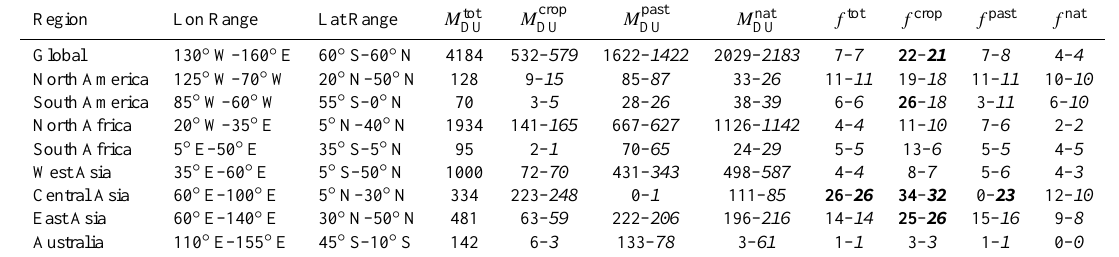
Table 1. Annual mean total burden of M-DB2 dust ( M DU ) in units of ktons as well as the fraction (%) of dust mixed with NH 3 over all land cover types ( f tot ), cropland ( f crop ), pasture ( f past ), and with less than 30% land-use ( f nat ), for the Klein Goldewijk (2001) and Ramankutty and Foley (1999) (in italics) landuse datasets, over 9 regions which boundaries are defined by their minimum and maximum latitude (Lat) and longitude (Lon). Percentage fraction greater than 20% are indicated in bold font.